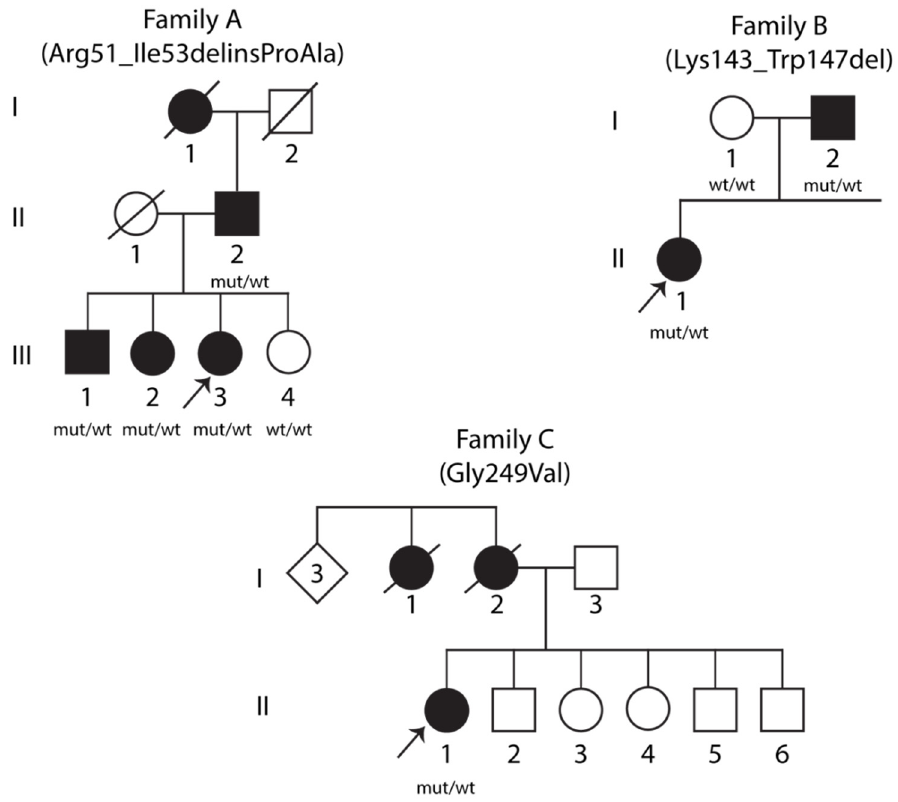
Figure 1. Pedigrees of three families with SCA48. Clinically affected individuals are indicated by filled symbols. Arrows denote the probands. Genetic statuses of examined individuals are provided below the symbols, where “mut” represents the mutant allele and “wt” represents the wild-type